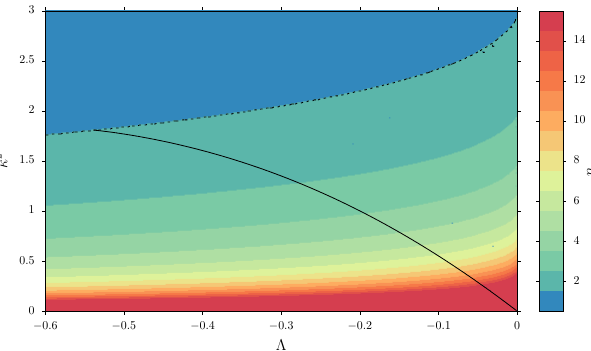
Figure 13 . n max as a function of (cid:3) and (cid:20) 2 , for 1 The continuous black line separates positive and negative energy excess for charge n solitons. Here (cid:21) = (cid:22) =